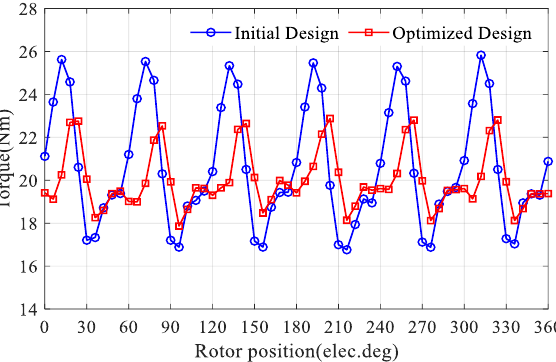
Figure 11. Electromagnetic torque comparisons of the initial and optimized machines.